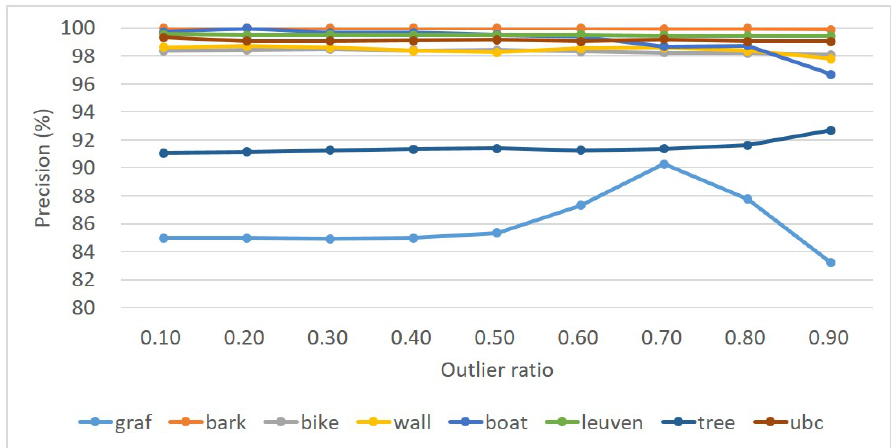
Figure 9. Statistical results for the precision for the eight sequences in dataset 1.